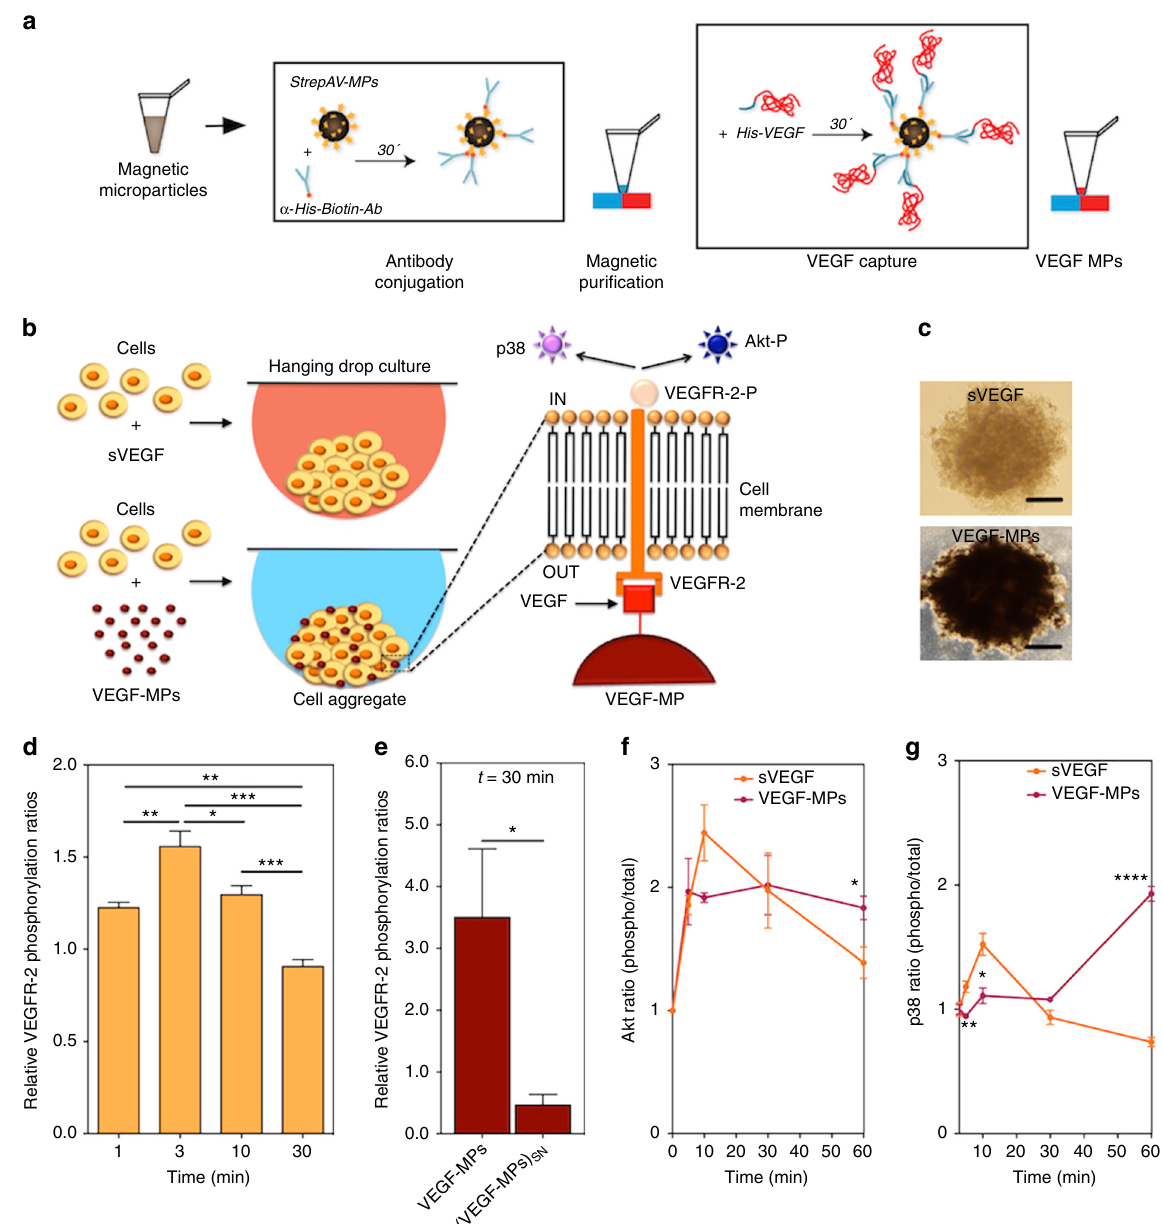
Fig. 1 Preparation of VEGF-MPs and biological characterization in OEPCs. a Schematic representation of the protocol for the preparation of VEGF- conjugated particles and b for the formation of cell aggregates containing sVEGF or VEGF-MPs. c Light microscopy images of the OEPC aggregates at 24 h. The differences in color of cell aggregates are due to the presence of MPs. Bar corresponds to 50 μ m. d VEGFR-2 phosphorylation in OEPC aggregates cultured in media containing sVEGF. e VEGFR-2 phosphorylation in OEPC aggregates containing VEGF-MPs or containing cell culture media exposed to the same number of MPs used to make the cell aggregates [(VEGF-MPs) SN ]. VEGF phosphorylation was quanti fi ed by ELISA. Values are given as average ± SEM ( n = 4 – 8). f , g ELISA quanti fi cation of phospho-Akt/total Akt ( f ) and phospho-p38/total p38 ( g ). Values are given as average ± SEM ( n = 3). In d , statistical analyses were performed using one-way ANOVA followed by a Bonferroni post test. In e – g , unpaired t -test was performed between groups. * P ≤ 0.05, ** P ≤ 0.01, *** P ≤ 0.001, and **** P ≤